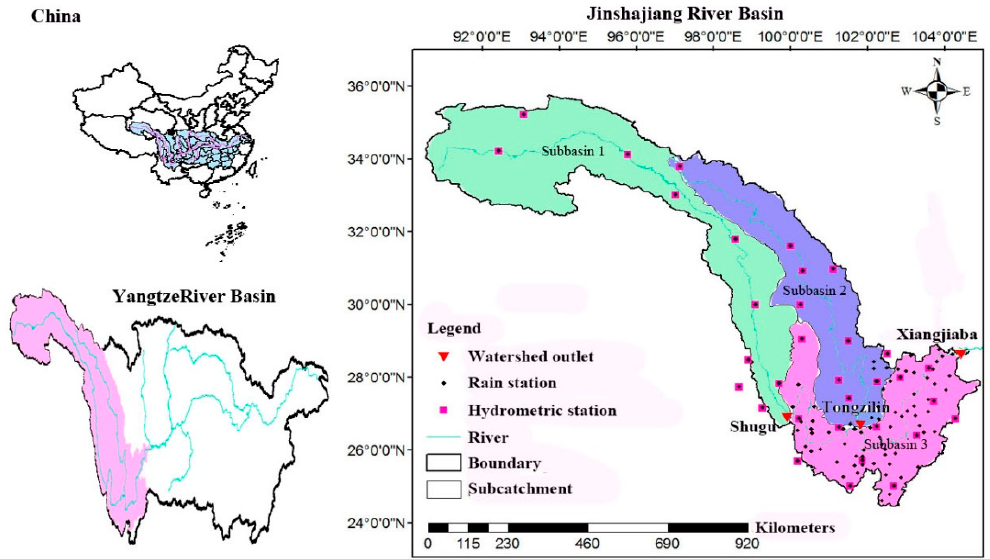
Figure 2. Jinshajiang River Basin [42].